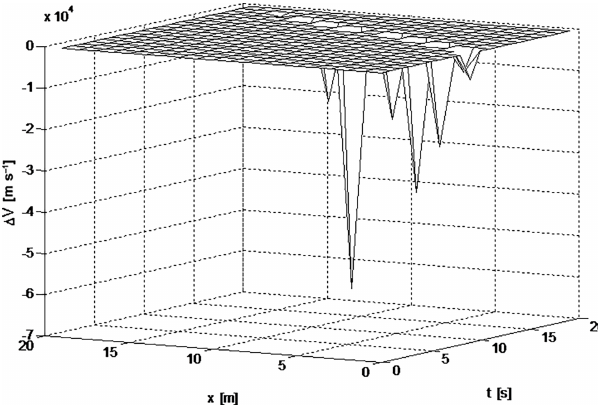
Figure 4. Propagation of initial sliding in the form of a triangular function f (z) of zero